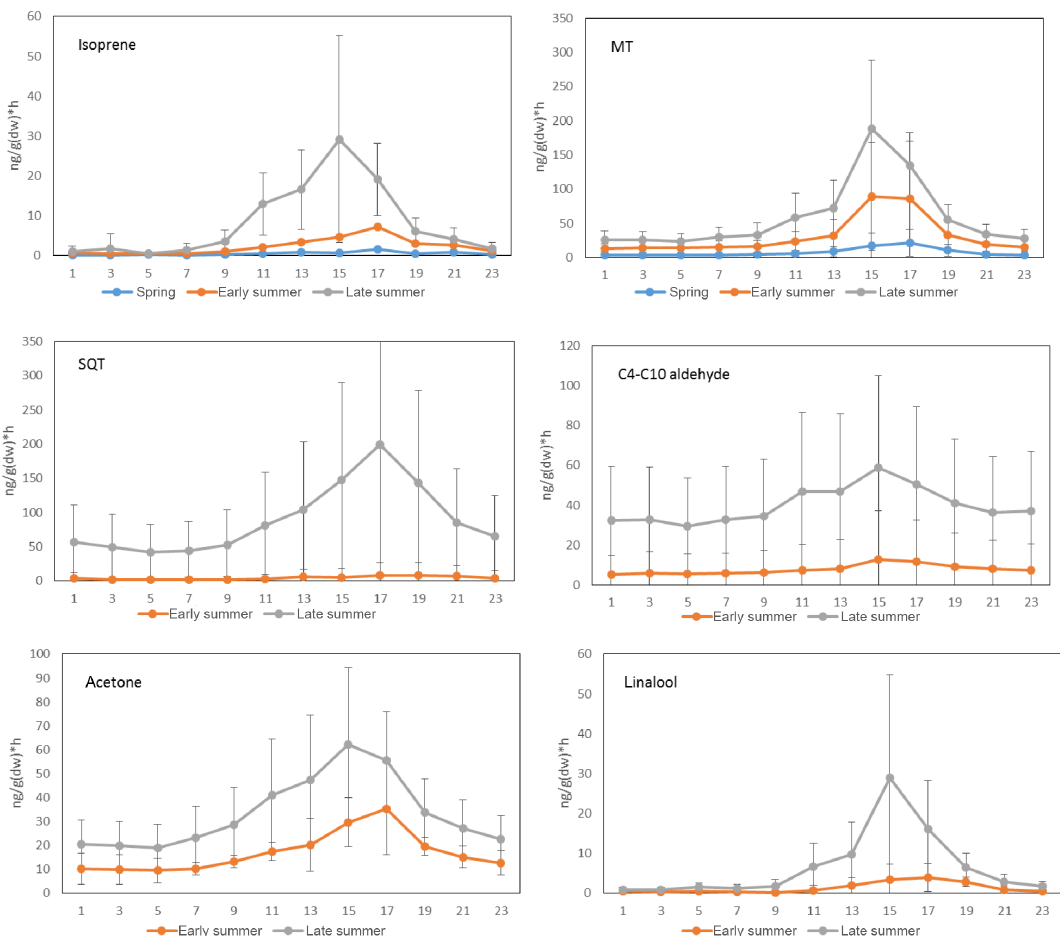
Figure 3. Mean diurnal variations of different compound groups in each season. Spring refers to April and May; early summer, June–mid- July; late summer, mid-July–August. Aldehydes are the sum of all C 4 –C 10 aldehydes (butanal, pentanal, hexanal, heptanal, octanal, nonanal, and